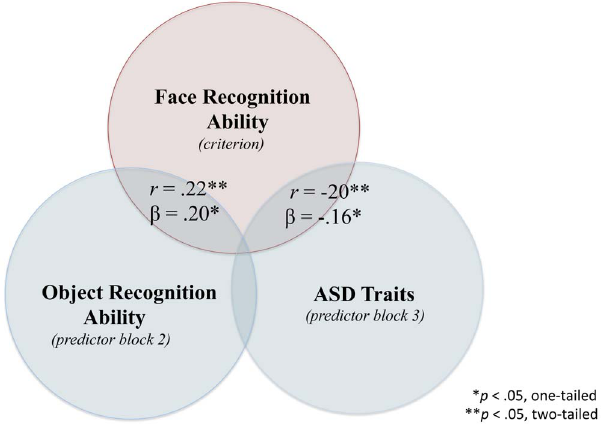
Figure 2. Venn representation of hierarchical regression analysis with face recognition ability (IM Face) as the criterion variable showing shared and unique variance with predictor variables. The variables presented are ‘‘selective’’ (i.e., gender and major are omitted from the diagram), however their effects are controlled for in the betas reported. Selected predictor variables include object recognition (IM Bird) and ASD traits (AQ) with b values reported at the stage the variable was entered. The overlap between predictors is not represented to scale and is for illustrative purposes.